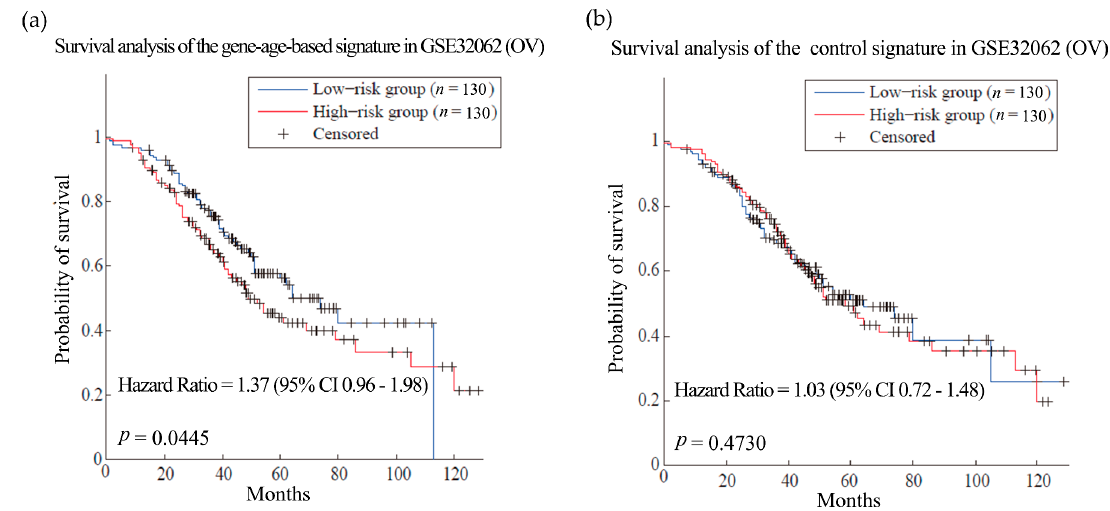
Figure 4. Survival analysis of the ovarian cancer dataset. ( a ) and ( b ) are the predictions of the ovarian cancer (OV) prognosis model using gene-age-based signatures and control signatures in independent test sets GSE32062 separately.